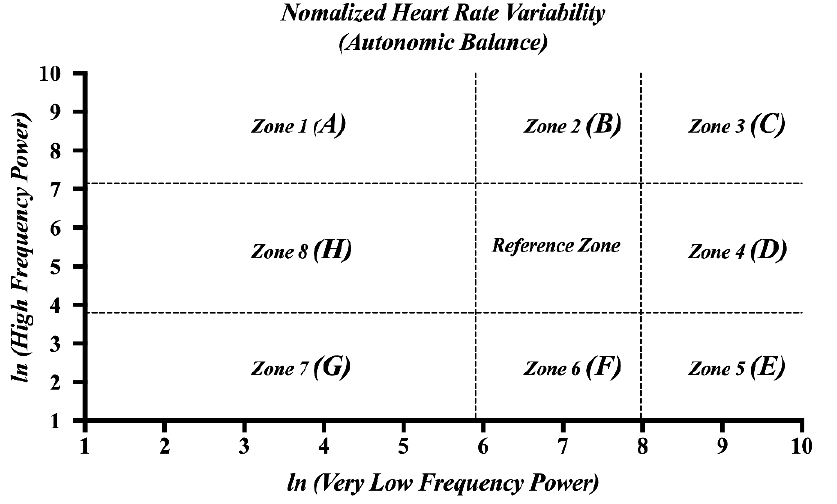
Figure 2. Zone definitions of normalized HRV. ( A ) Zone 1: High parasympathetic/low sympathetic. ( B ) Zone 2: High parasympathetic/normal sympathetic. ( C ) Zone 3: High dual autonomic tone. ( D ) Zone 4: High sympathetic/normal parasympathetic. ( E ) Zone 5: High sympathetic/low parasympathetic. ( F ) Zone 6: Normal sympathetic/low parasympathetic. ( G ) Zone 7: Low sympathetic and parasympathetic. ( H ) Zone 8: Low sympathetic/normal parasympathetic.